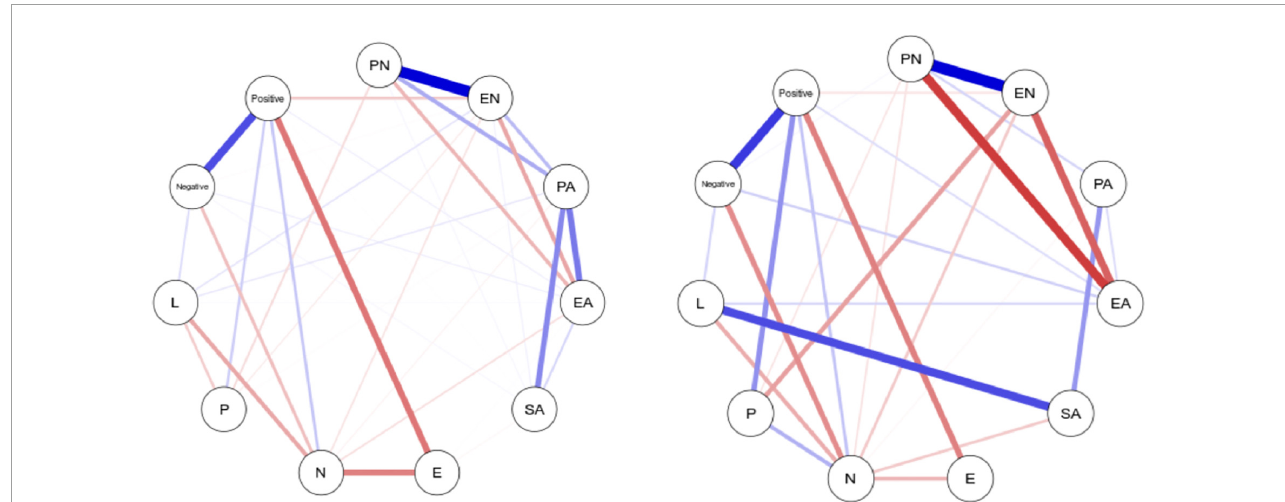
FIGURE1 Network plot of the seven dimensions of the five types of CM, personality characters, and the scores for coping style (EN, emotional neglect; EA, emotional abuse; PN, physical neglect; PA, physical abuse; SA, sex abuse; N, neuroticism; E, extraversion; P, psychoticism; L, lie scale; Positive, positive coping; Negative, negative coping). Edges represent regularized partial correlations, where thicker edges represent stronger connections. Blue edges represent positive correlations, whereas red edges represent negative correlations.